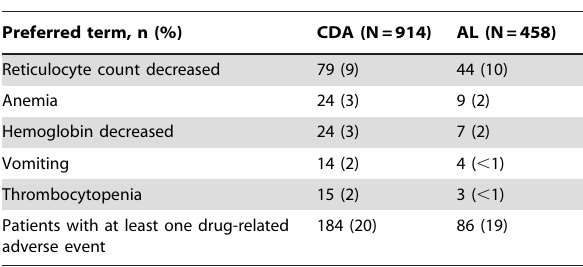
Table 5. Most frequent investigator-reported treatment- emergent drug-related adverse events reported in the ITT (safety) population ( $ 2% of patients in either treatment